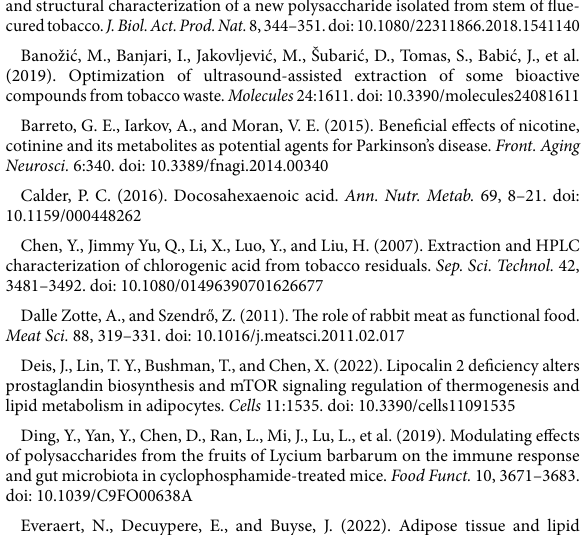
SUPPLEMENTARY FIGURE S3 Heatmap of differential metabolites between CK and LNT (TT) groups, positive ion mode. SUPPLEMENTARY FIGURE S4 Heatmap of differential metabolites between CK and LNT (TT) groups, neg ion